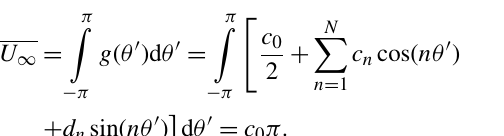
wind speed U ∞ ( θ (cid:48) ), and the wind direction frequency f ( θ (cid:48)